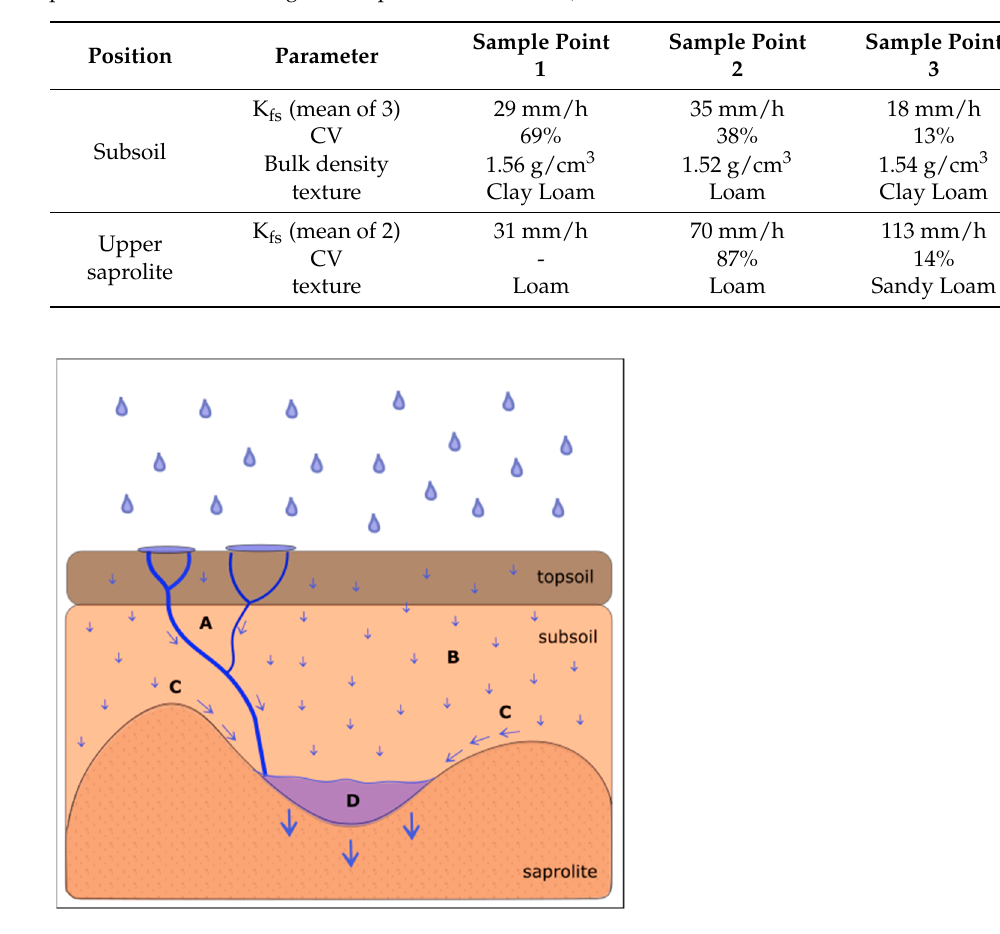
Figure 4. Schematic representation of the “fill-and-drain” mechanism at the soil–saprolite interface. Rainwater is conducted to the soil–saprolite interface via macropores (A) or via matrix flow (B) in the topsoil and subsoil. Infiltrating water is deflected to the depressions in the saprolite topography as a result of capillary diversion (C). When saturated conditions are reached in the depressions, a complete breakthrough occurs, and water is transmitted to the saprolite